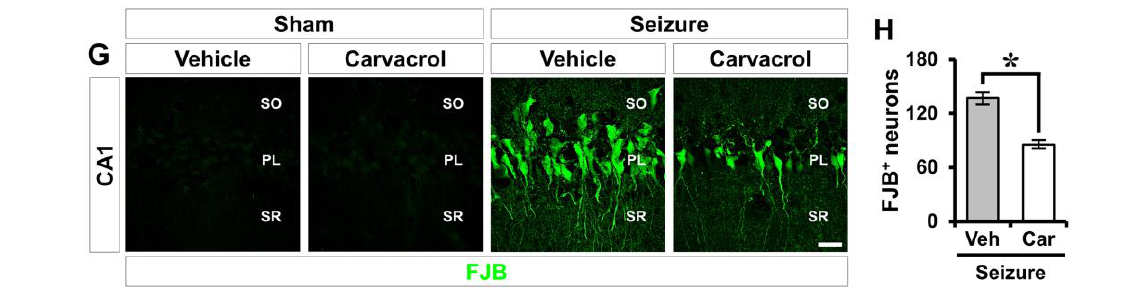
Figure 2. Carvacrol treatment reduces TRPM7 overexpression, zinc accumulation, and neuronal degeneration after seizure. ( A ) Representative images showing TRPM7 immunoreactivity (green) in the CA1 of the hippocampus. Nuclei are counterstained with DAPI (blue). Scale bar = 20 µm. ( B ) The bar graph representing the immunofluorescence intensity of TRPM7 as determined in the same hippocampal region (mean ± SEM; n = 5 from each sham group, n = 7 from each seizure group). * p < 0.05 vs. the vehicle-treated group; # p < 0.05 vs. the sham-operated group (Kruskal – Wallis test followed by a Bonferroni post-hoc test: chi square = 19.452, df = 3, p < 0.001). ( C ) Western blot analysis of TRPM7 in the hippocampus. ( D ) Quantification of TRPM7 protein levels from the hippocampus. (mean ± SEM; n = 5 from each sham group, n = 7 – 8 from each seizure group). * p < 0.05 vs. the vehicle-treated group; # p < 0.05 vs. the sham-operated group (Kruskal – Wallis test followed by a Bonferroni post-hoc test: chi square = 12.310, df = 3, p < 0.006). ( E ) Representative images showing sections of the hippocampus stained with TSQ to detect zinc accumulation. Scale bar = 100 µm. ( F ) Bar graph showing the number of TSQ + neurons in the hippocampal CA1 (mean ± SEM; n = 6 from each sham group, n = 5 from each seizure group). * p < 0.05 vs. the vehicle-treated group (Mann – Whitney U test: z = 2.611, p = 0.008). ( G ) Fluorescent images representing the degenerating neurons stained with Fluoro-Jade B (FJB) in the hippocampal CA1. Scale bar = 20 µm. ( H ) Quantification of the number of FJB + neurons (mean ± SEM; n = 5 from each sham group, n = 8 from each seizure group). * p < 0.05 vs. the vehicle-treated group (Mann – Whitney U test: z = 1.785, p = 0.074).